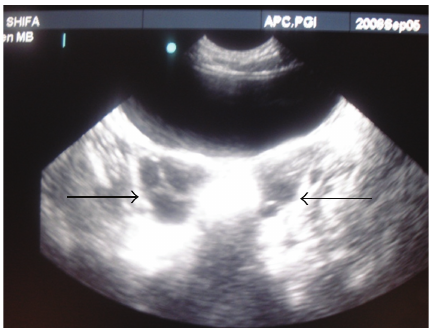
Figure 1: Ultrasonogram showing multicystic ovaries (Rt > Lt).